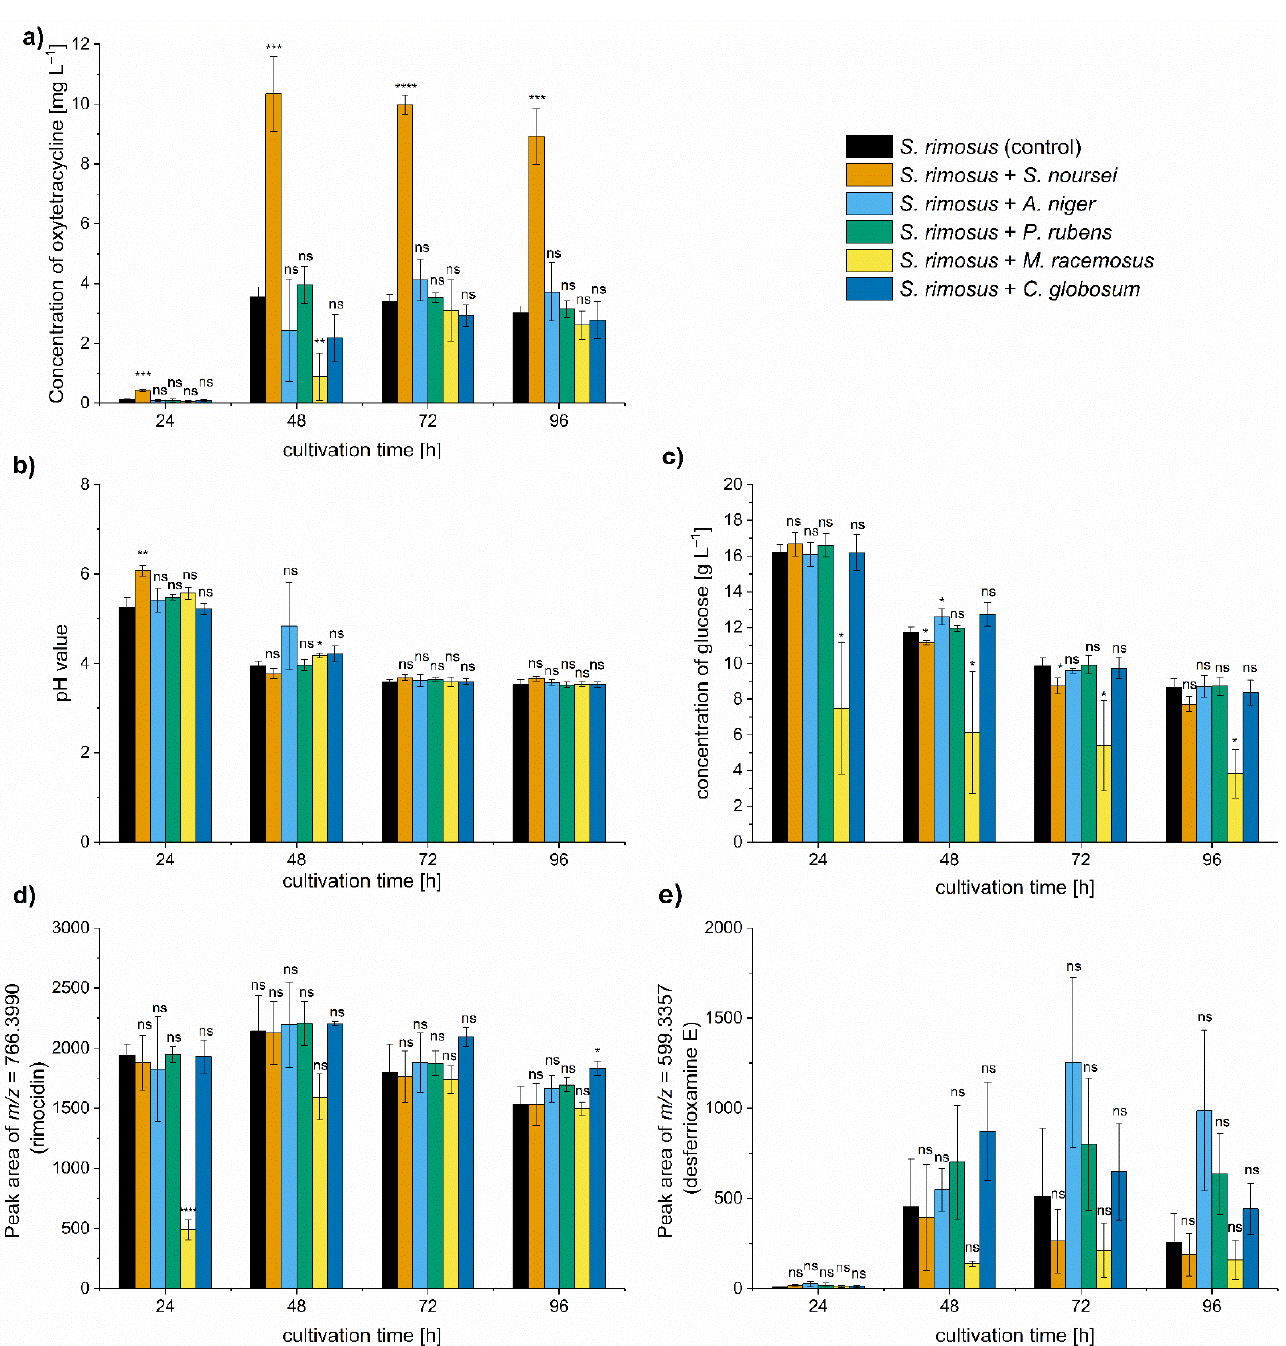
Figure 1. The values of oxytetracycline concentration ( a ), pH ( b ), glucose concentration ( c ), peak area corresponding to rimocidin ( d ), and desferrioxamine E ( e ) after 24, 48, 72, and 96 h of submerged co-cultivation of S. rimosus with S. noursei , A. niger , P. rubens , M. racemosus, or C. globosum in shake flasks. The inoculation with the use of spores was performed in all presented cases. The results are given as mean ± SD from three independent experiments ( n = 3). The two-sample t-test was performed to indicate whether the results obtained for the co-cultures differed significantly from the ones recorded for the S. rimosus monoculture controls. * p ≤ 0.05, ** p ≤ 0.01, *** p ≤ 0.001, **** p ≤ 0.0001, ns—not significant. The peak areas are given in auxiliary units.